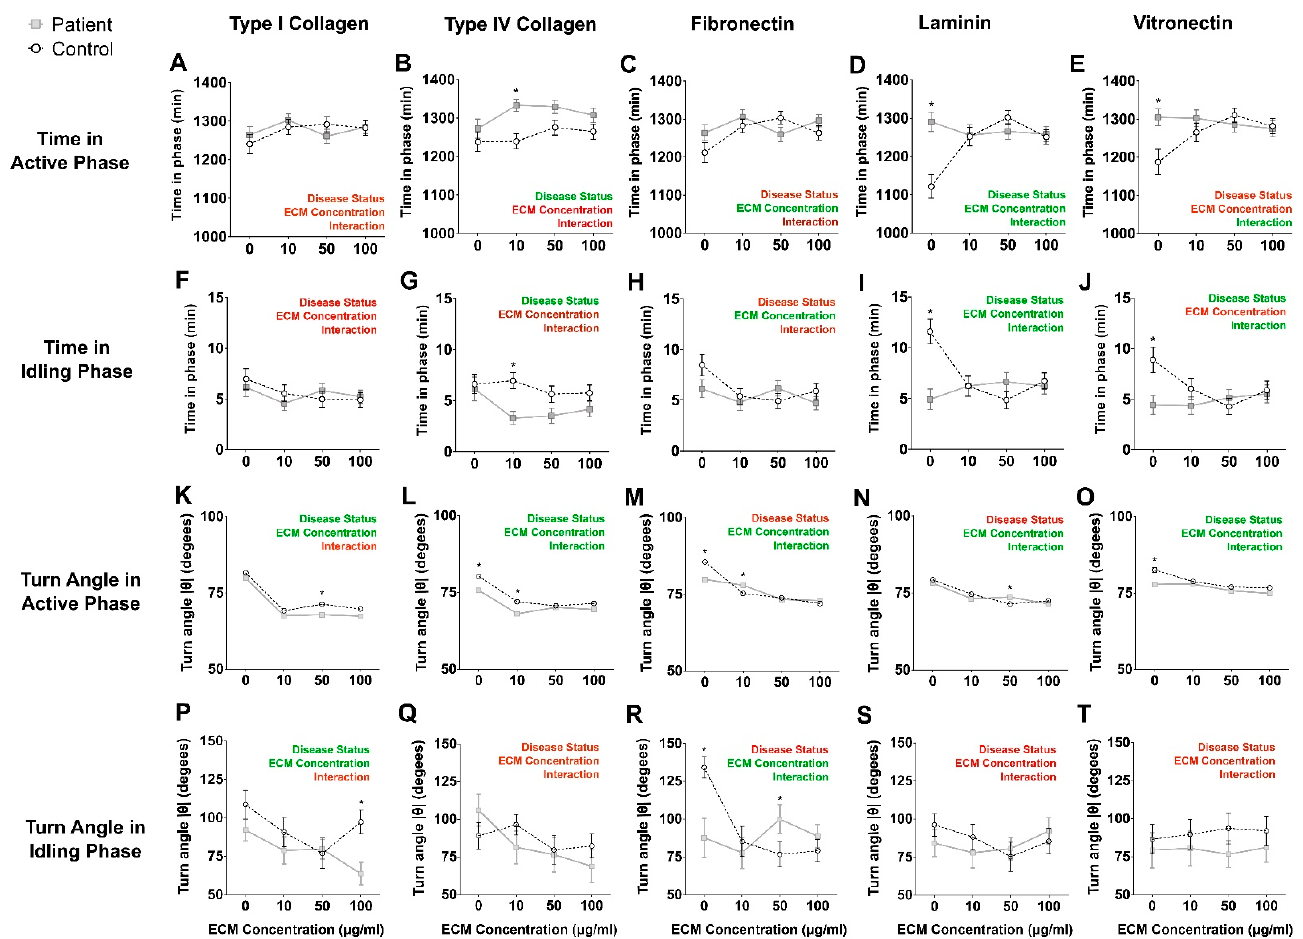
Figure 4. Patient cell and control cell active and idling phases and turn angles were similar on different ECM protein substrates. ( A – E ): Time in Active Phase values for patient and control cells migrating on the ECM proteins at different concentrations. ( F – J ): Time in Idling Phase values for patient and control cells migrating on the ECM proteins at different concentrations. ( K – O ): Turn Angles after Active Phase for patient and control cells migrating on the ECM proteins at different concentrations. ( P – T ): Turn Angles after Idling Phase for patient and control cells migrating on the ECM proteins at different concentrations. All data are presented as the mean track distance ± S.E.M. Control cells: open circles with black dotted lines ( n = 9 independent cell lines). Patient cells: closed grey squares with grey solid lines ( n = 9 independent cell lines). Two-way ANOVA was used to compute the main effects of: disease status, ECM protein concentration and whether an interaction exists between the two main effects. Summary of statistical test is presented in each graph as “Disease status”, “ECM concentration” and “Interaction”; red: p > 0.05, green p < 0.05. Detailed ANOVA results are presented in Supplementary Tables S4–S8. * = p < 0.05, Tukey post hoc tests.